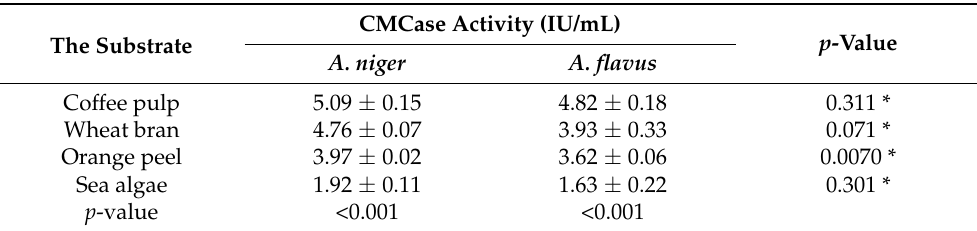
Table 4. Production of CMCase under SSF by A. niger and A. flavus using lignocellulolytic biomass as substrates.